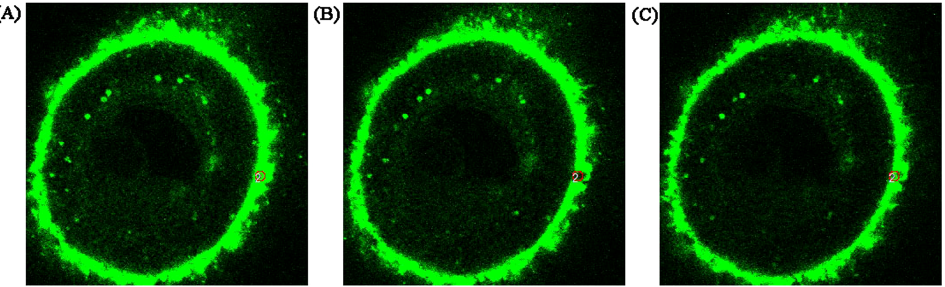
Figure 5. Fluorescence images of membrane phospholipids of HNECs by tomoscan. (A) Before photobleaching, the fluorescence on membrane phospholipids of HNEC was green and well-distributed. (B) After photobleaching, the fluorescence disappeared. (C) Due to membrane fluidity, the fluorescence probe from other areas can move to the photobleaching position leading to the recovery of fluorescence.